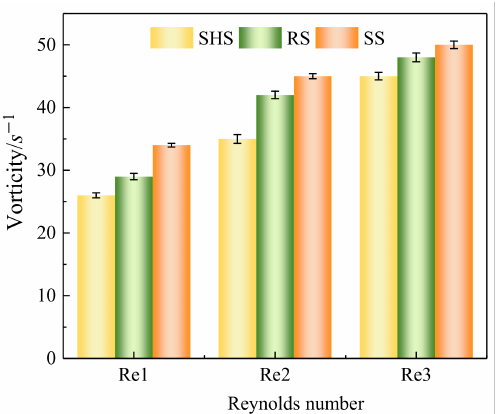
Figure 6. Maximum value of vorticity. Note: SHS, RS, and SS are the superhydrophobic surface, the riblet surface, and the smooth surface, respectively.